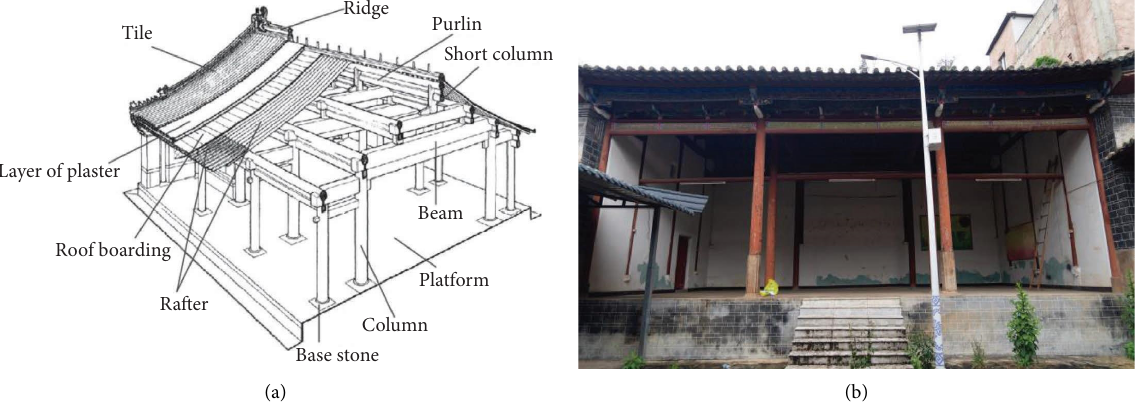
Figure 1: Traditional Chuan-Dou style wooden structure: (a) 3D view of timber frame with laminated beams and columns. (b) A typical Chuan-Dou style wooden structure folk house in Southwest